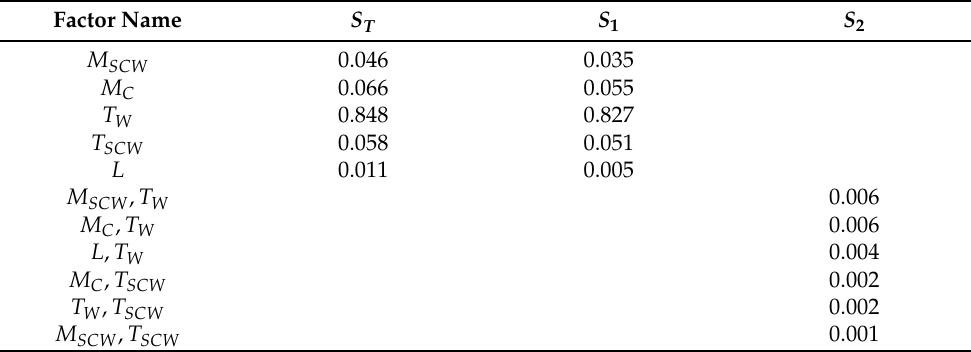
Table 6. Global sensitivity analysis of five parameters on the CE of the SCWFB